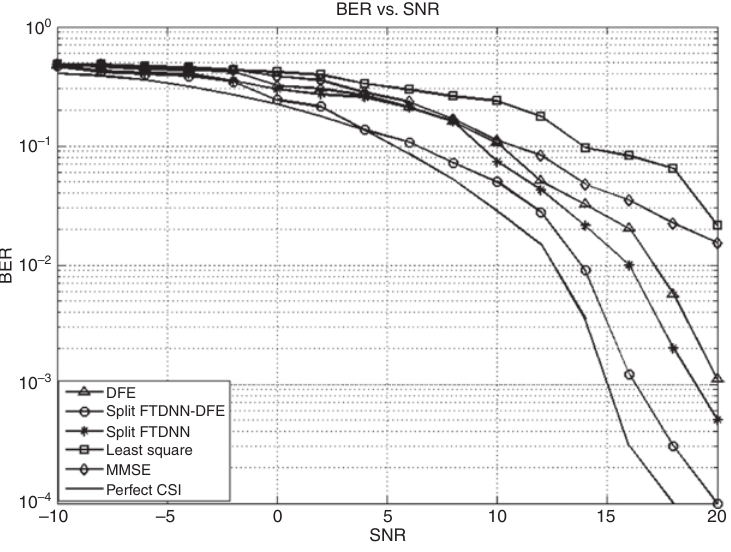
Figure 18: BER-SNR Comparison Plot.